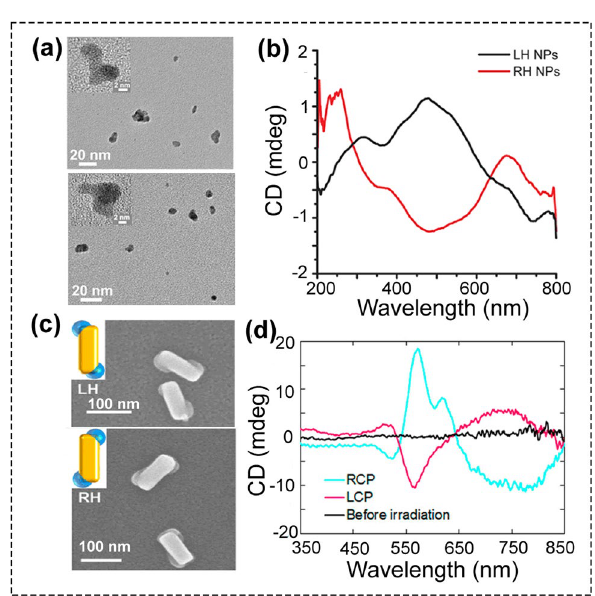
Fig. 4 a TEM images and b of the chiral LH and RH AuNPs, which were prepared under the irradiation of LCP and RCP light, respec- tively (reproduced with permission from Ref. [81]. Copyright 2019 American Chemical Society). c SEM images of the chiral LH and RH Au-PbO2 nanostructures. d CD spectra of the TiO2 substrate with gold nanocuboids before (black line) and after PbO2 deposition by RCP (blue line) or LCP (red line) light irradiation (reproduced with permission from Ref. [82]. Copyright 2018 American Chemical